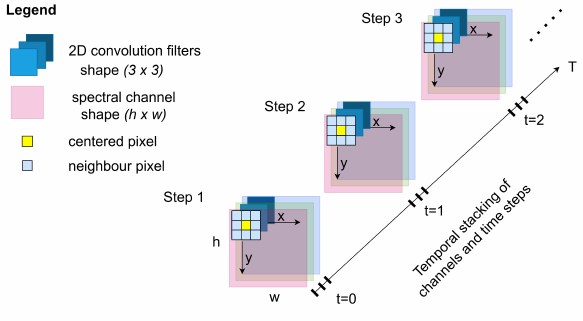
Figure 3. Representation of a 2D convolution using temporal stacking. Only the three first sliding steps are depicted.